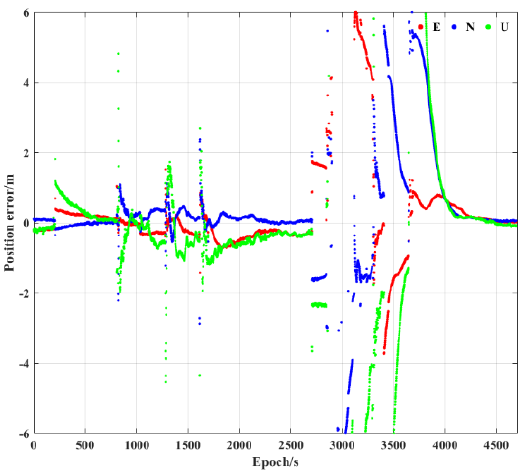
Figure 5. The position error of PPP in the experiment. Table 1. Precision specifications of the above IMUs utilized in the experiment.